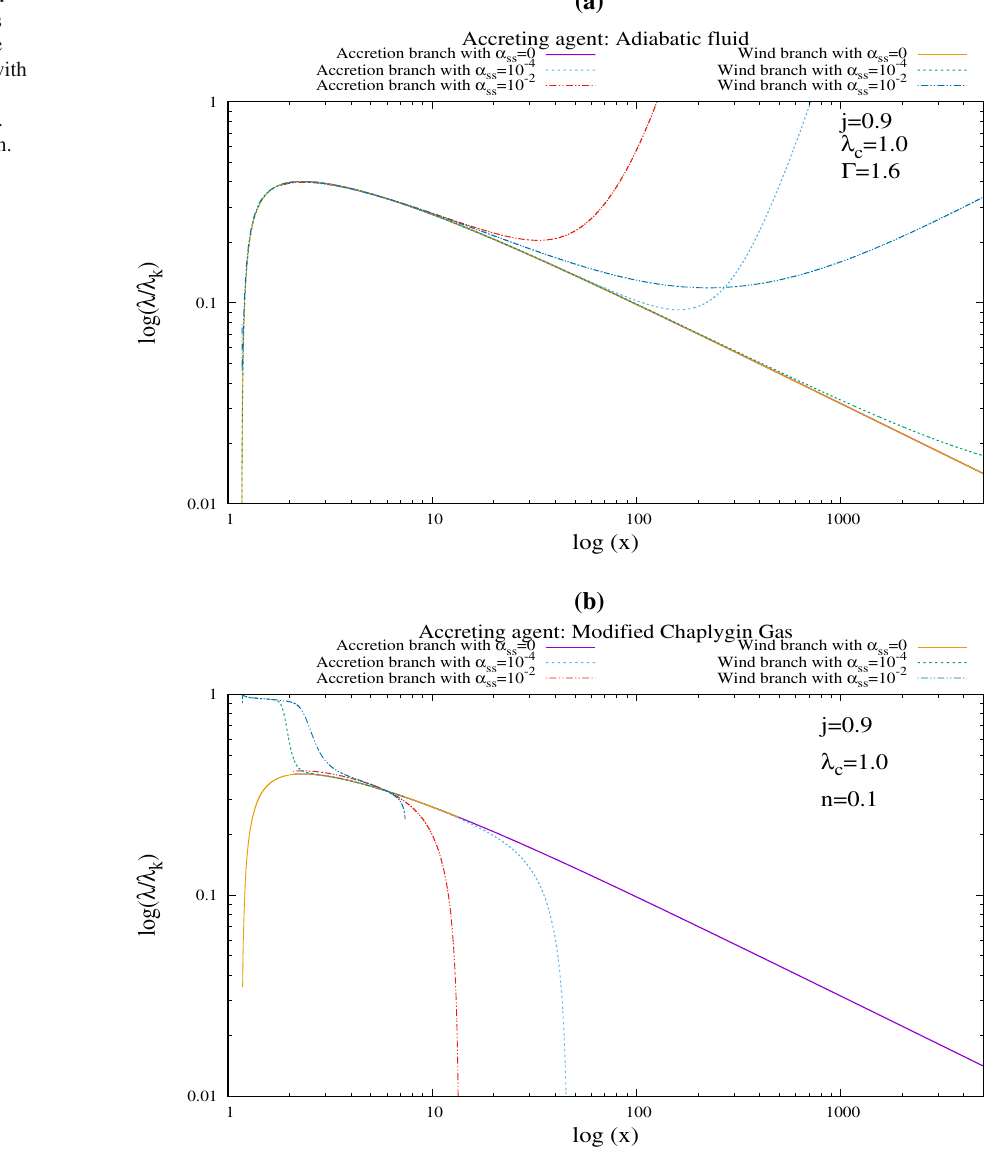
Fig. 6 Plots of accretion and wind branches for log ( λ λ log ( x ) for rotating black hole ( spin parameter J = 0 . 9) with different viscosity parameter (showed in different colours). a For adiabatic fluid accretion. b For MCG